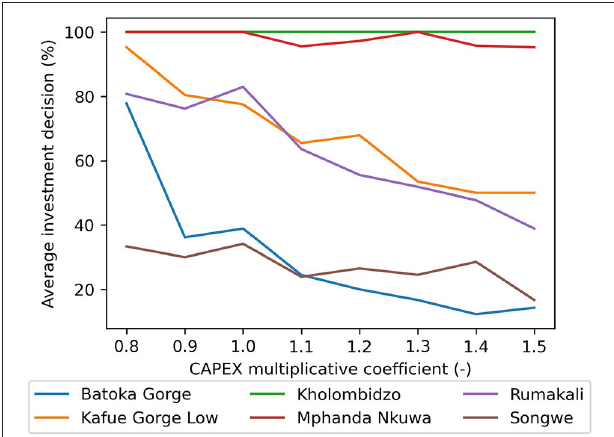
FIGURE 11 | Sensitivity analysis of the main hydropower dams to capital investments costs.